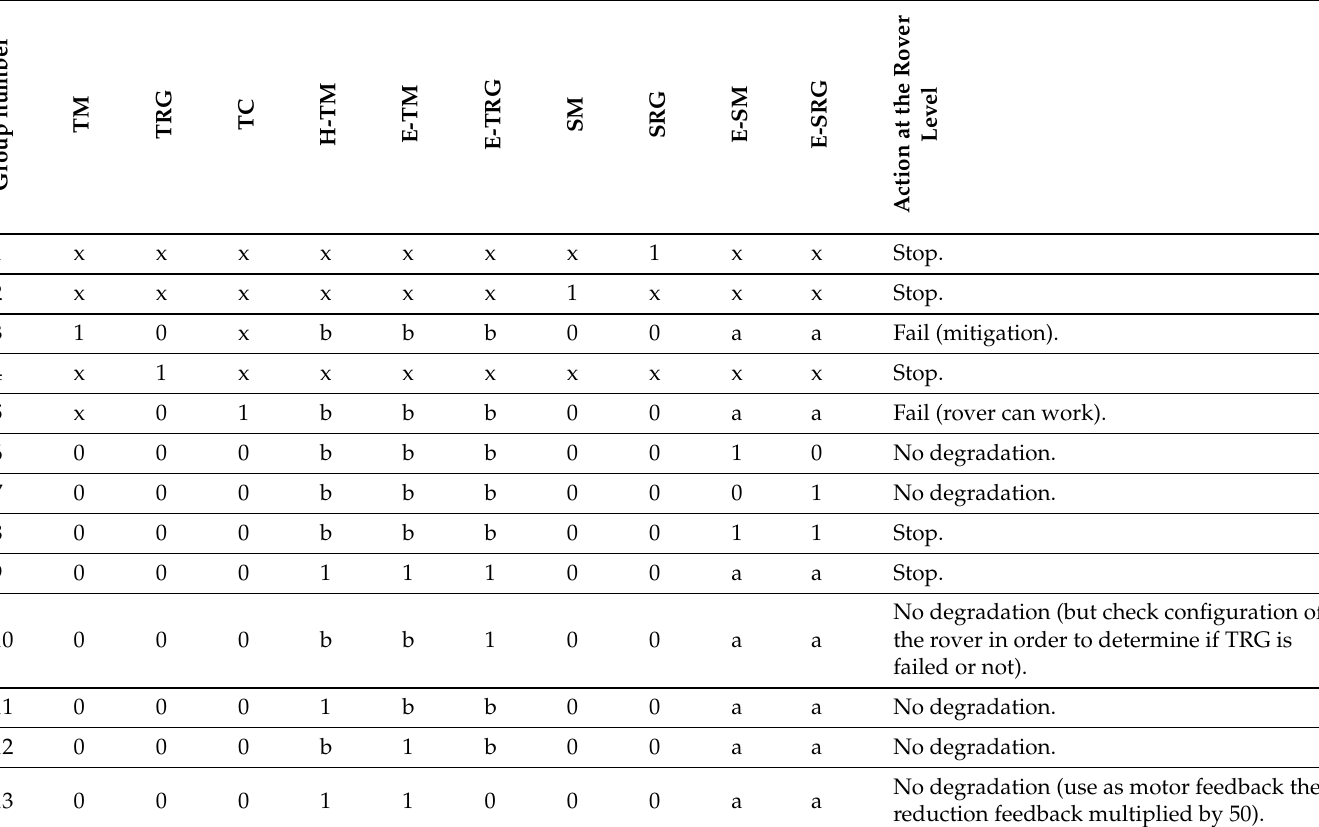
Table 1. Failure grouping summary. Here, 0 indicates that the component is fault-free, while 1 indicates that the component failed. The characters “a”, “b” and “x” indicate what components can fail in each group: components marked as “x” can fail simultaneously in any number between 0 and 9; components marked as “a” can fail simultaneously in a maximum number of 2; and components marked as “b” can fail simultaneously in a maximum number of 3 for groups numbered 3, 5, 6, 7, 8 or in a maximum number of 2 for groups numbered 10, 11,